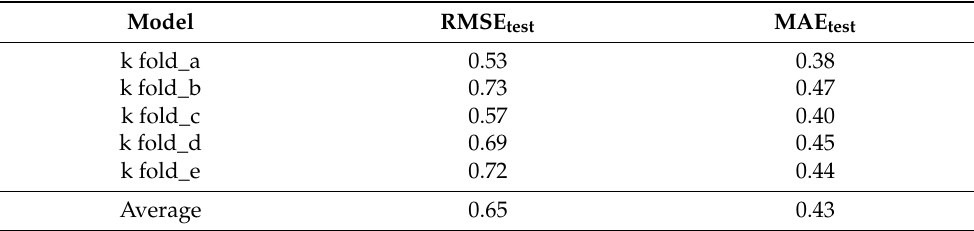
Table 3. Averages of RMSE test and MAE test resulting from five-fold cross-validation based on Dataset 3.